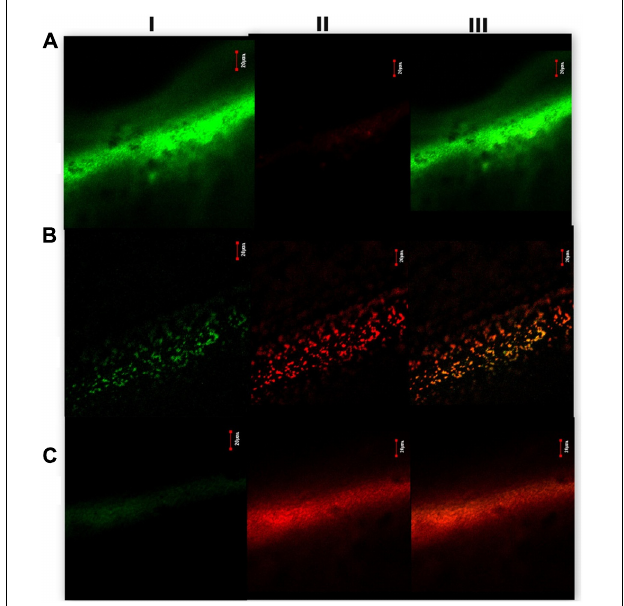
FIGURE 4 | Confocal laser scanning microscope images of biofilm formed on urinary catheters. I—FITC labeled (green/viable cells); II—ethidium bromide labeled (red/non-viable cells); and III—superimposed images of I and II. (A) Control, untreated with ADM 3, (B) treated with ADM 3 (MBIC 50 at 5 µ g/mL), and (C) treated with ADM 3 (2 × MBIC 50 at 10 µ g/mL).